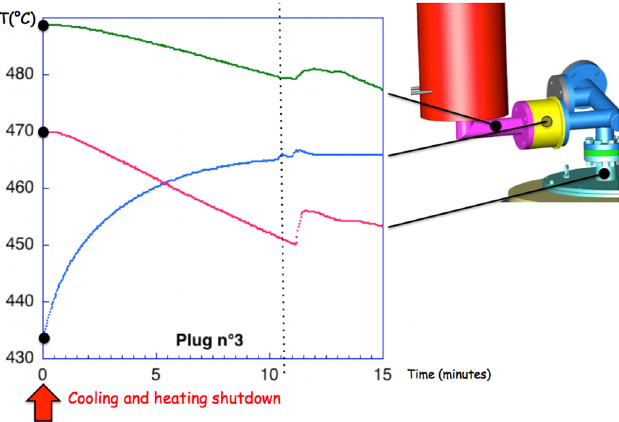
Fig. 5. Example of evolution of local temperatures during a cold plug